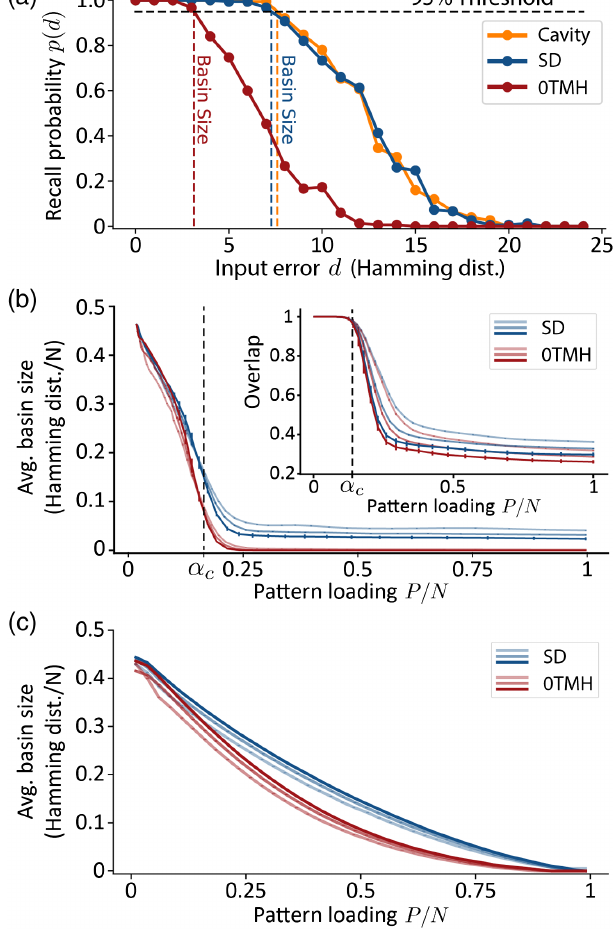
FIG. 10. (a) Recall probability as a function of the input error applied, quantified by the Hamming distance between the input and pattern state. This probability is plotted for three forms of dynamics: 0TMH (red), SD (blue), and CCQED (orange). The latter is given by Eq. (26). This plot illustrates how the dynamics affects recall probability and, thus, basin size (defined by the point where the recall curve drops below 95%). corresponding to a pseudoin- We use a connectivity matrix J ij verse Hopfield model with N ¼ 100 spins and P ¼ 0 . 6 N patterns stored. We choose this learning rule because it illustrates a large difference between the two dynamics. (b) Average basin size of attractors for connectivity of a Hebbian learning rule. The intensity of the trace increases with system size, N ¼ 200 , 400, 800, while color indicates the form of ≈ 0 . 138 marks the known pattern dynamics. The critical ratio α c loading threshold where Hebbian learning fails in the thermo- dynamic limit [16]. Inset: overlap between the attractor of the dynamics s μ and the bare memory ξ μ , as discussed in the text. (c) Average basin size for the pseudoinverse learning rule versus the ratio of patterns stored to number of nodes, P=N . Steepest descent dynamics outperforms 0TMH in all cases, yielding larger basin sizes for P=N ≳ 0 . 1 and, thus, greater memory